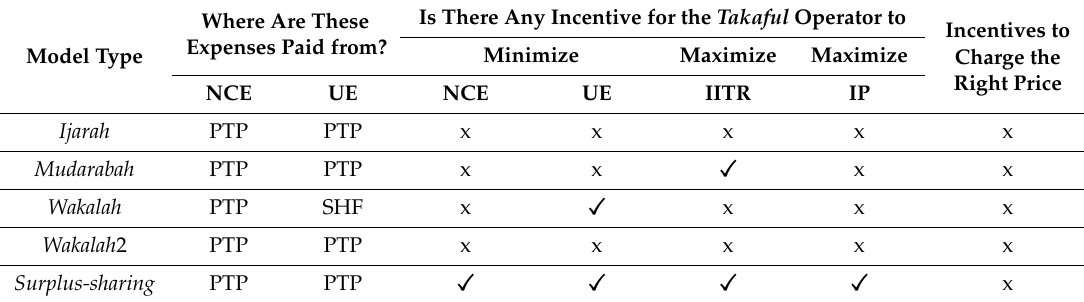
Table 1. Ability of di ff erent takaful models to induce the TO ( takaful operator) to work in the best interest of the